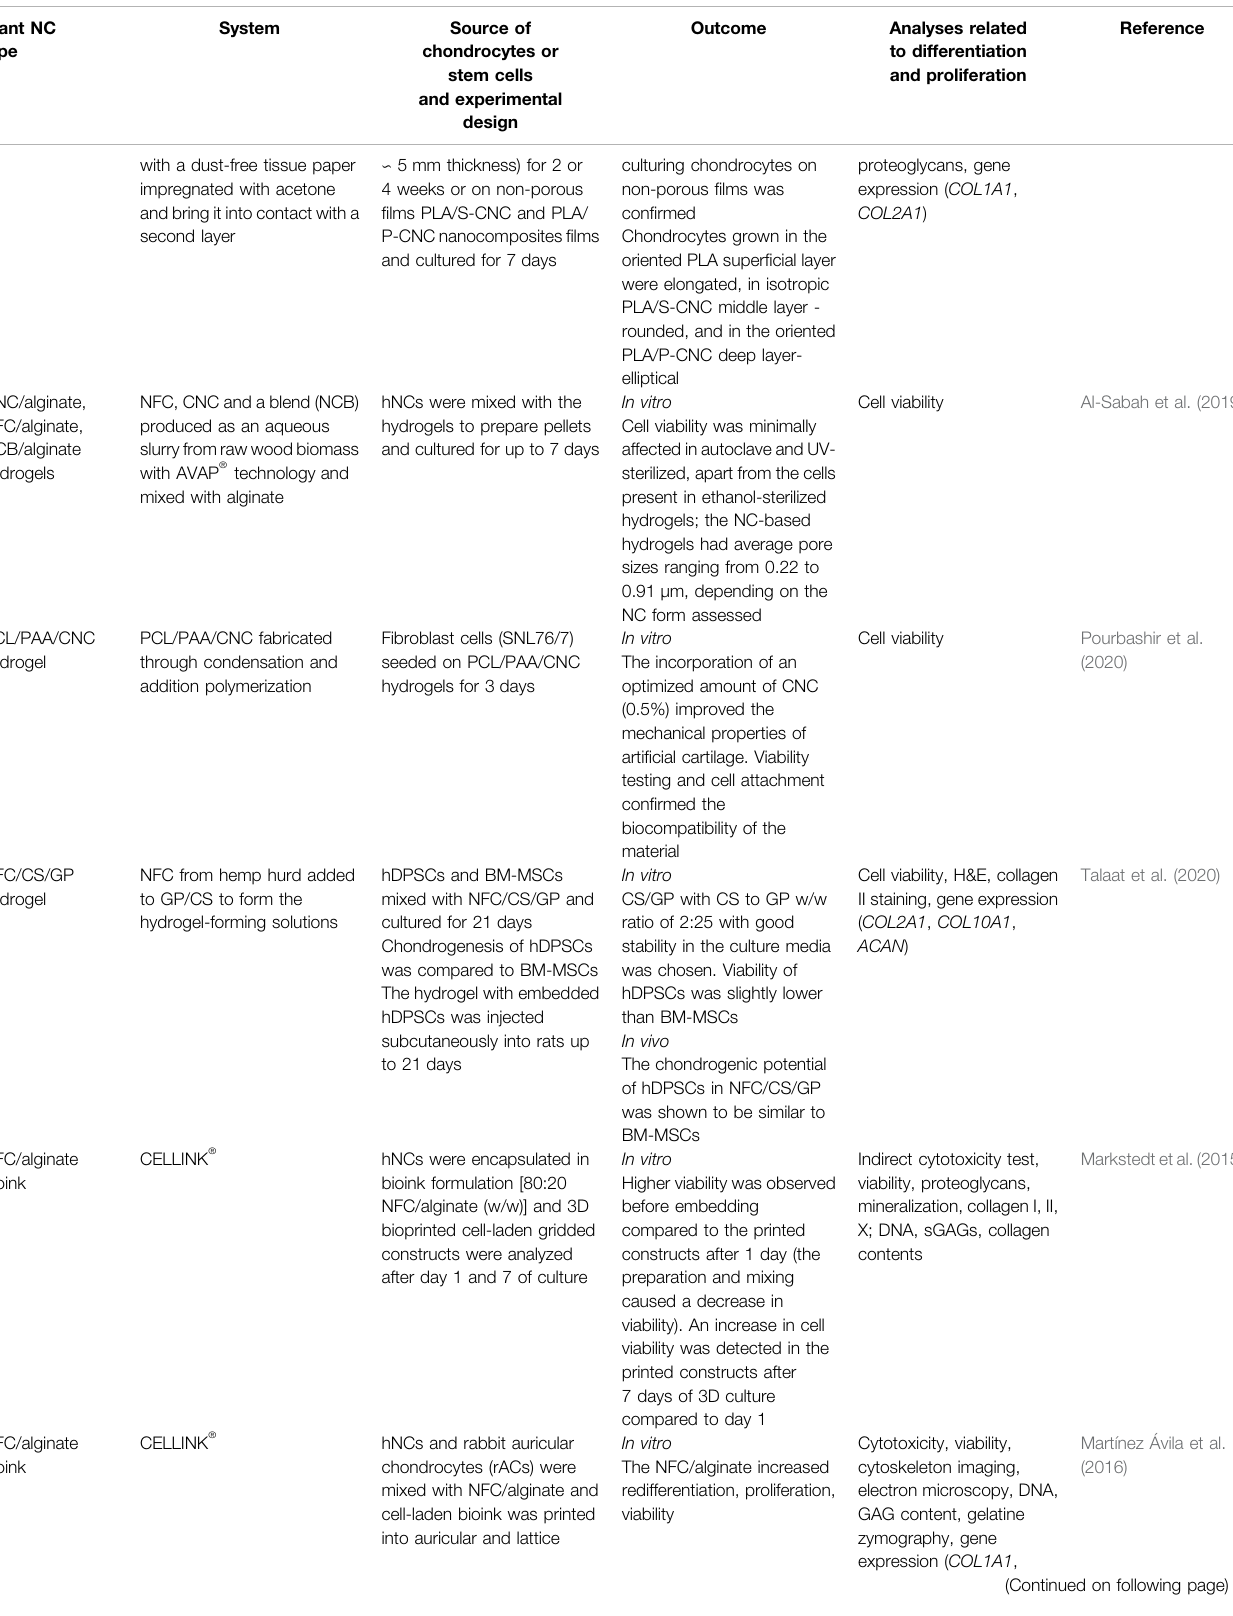
TABLE 1 | ( Continued ) Plant-derived NC applied to cartilage tissue